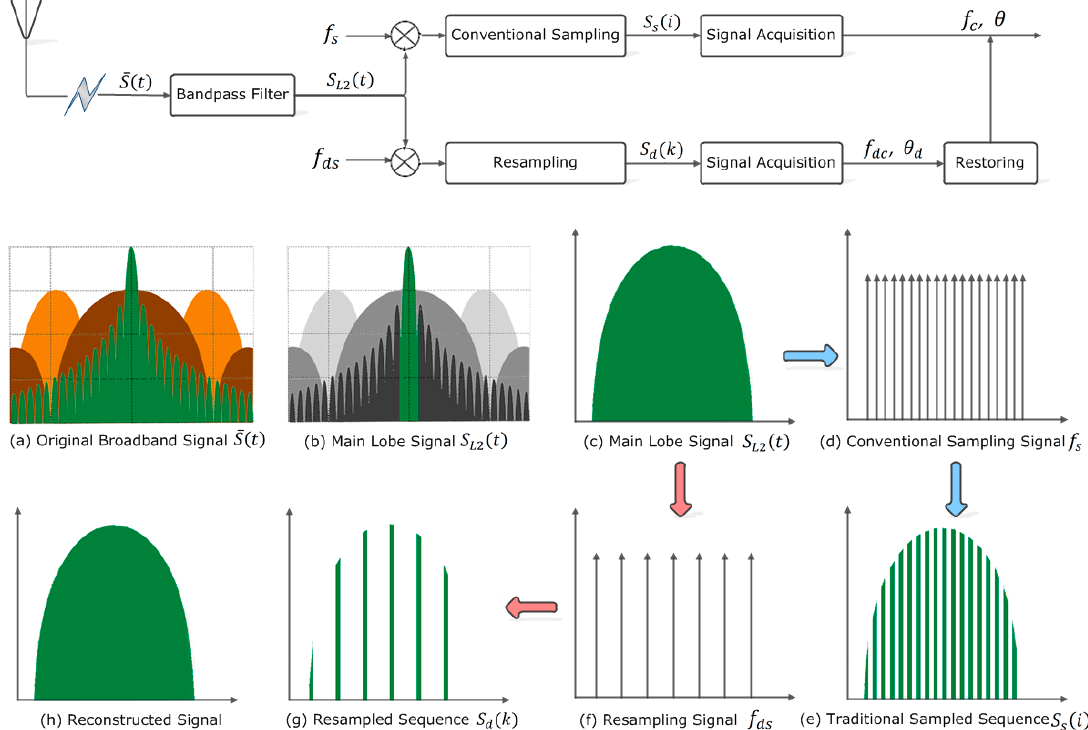
Figure 3. Signal flow chart by applying the resampling strategy and the convolutional method to the received broadband satellite signal. The green, dark brown, and orange represent frequency spectra of GPS L2C, P(Y), and M code signals, respectively.